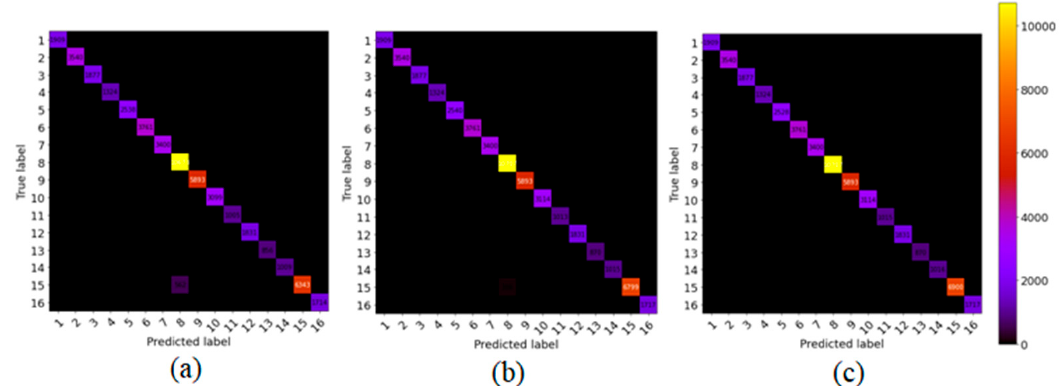
Figure 7. The confusion matrix for classification results of ( a ) SSRN, ( b ) HybridSN ( c ) GGBN over SA